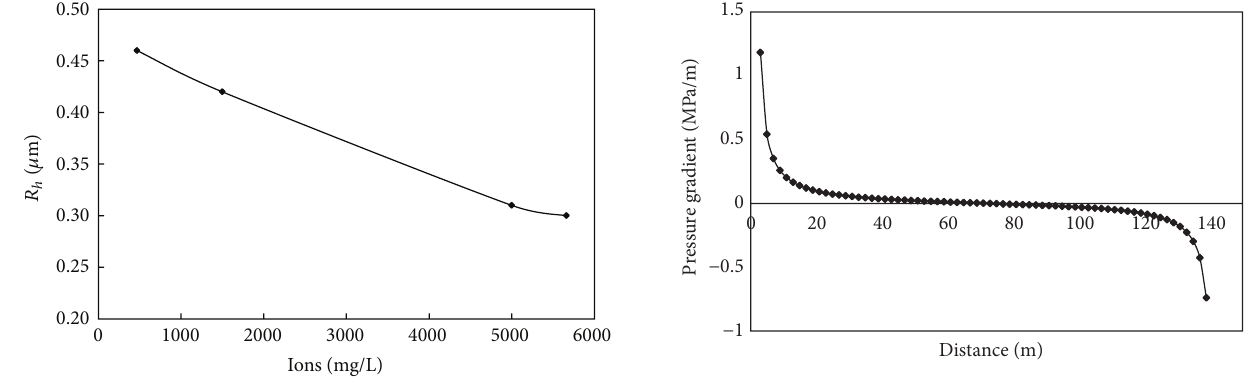
Figure 4: Relation between the hydrodynamic feature size and the water salinity.